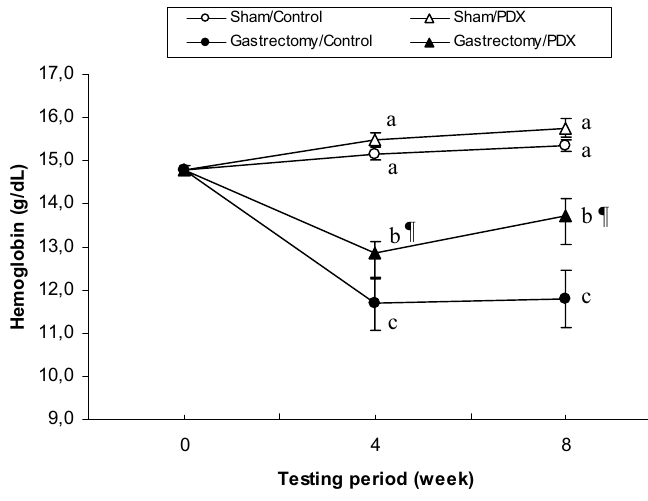
FIGURE 2 - Hemoglobin concentration in sham operated or rats with gastrectomy fed diets with polydextrose (PDX) or without polydextrose (control), at 0, 4 and 8 wk after the start of the feeding period. Each values represents the means ± SEM (Sham/Control: n=10; Sham/PDX: n=10; Gastrectomy/Control: n=9; Gastrectomy/PDX: n=9). All ANOVA main effects (treatment, diet and time) were significant. Diet (control or PDX) treatment (with or without gastrectomy) and time (0, 4, 8 wk) significantly larger than in gastrectomy control (without polydextrose). Point not sharing a common superscript are significantly different, p<0.05 (Duncan‘s multiple range